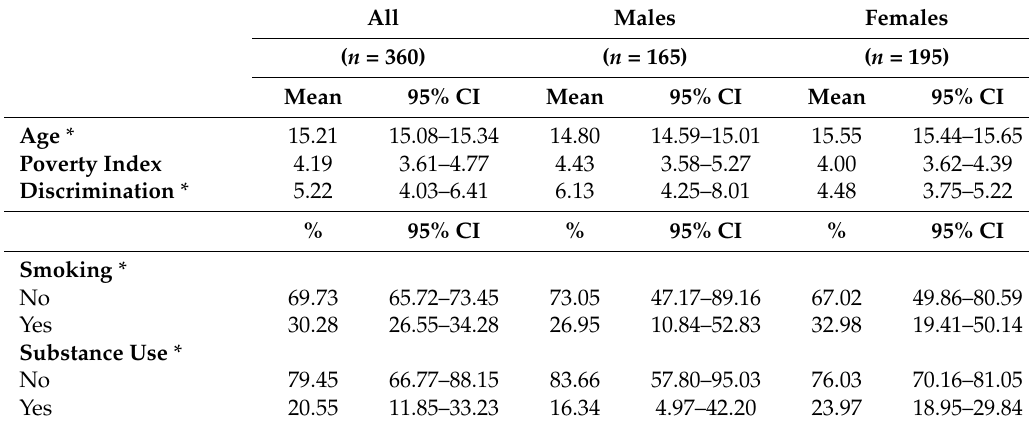
Table 1. Descriptive statistics in the pooled sample of Caribbean Black youth and based on gender All Males Females ( n =